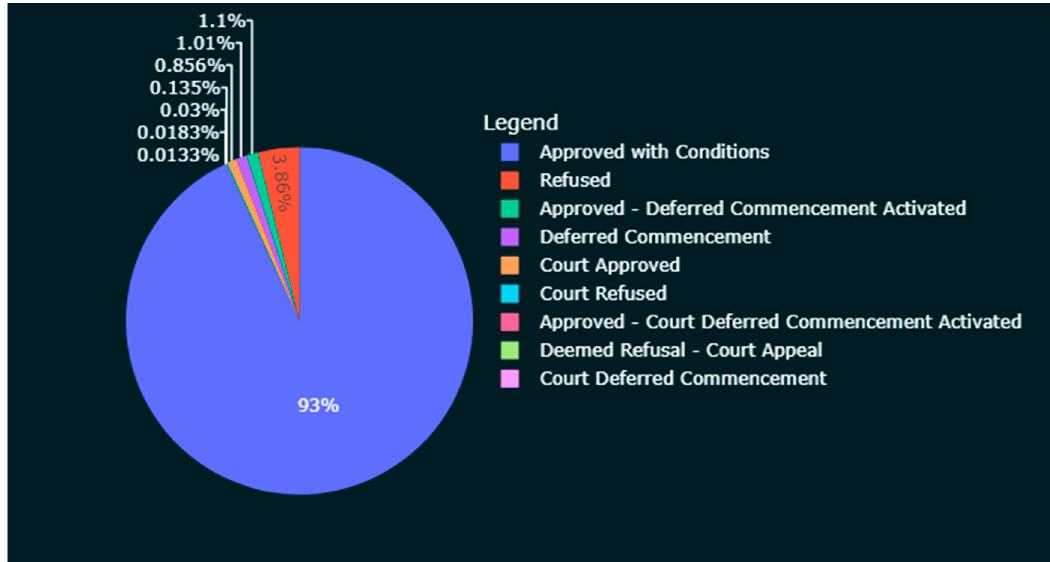
Figure 40. Average and median assessment time for all determined DAs by month (2004–2022).